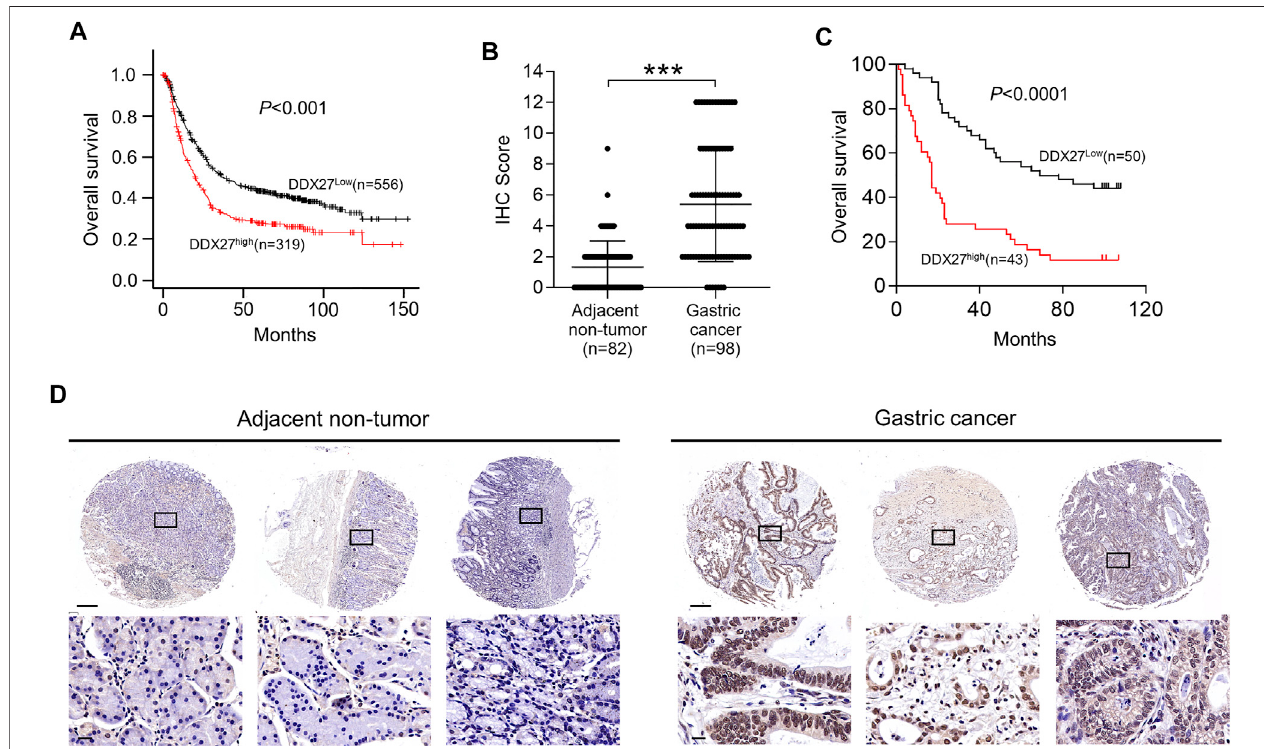
FIGURE2| HighDDX27expressionindicatedapoorclinicalprognosis. (A) Kaplan-Meieranalysisofoverallsurvival(OS)betweenGCpatientswithhigh( n =319)or low( n =556)DDX27expressionfromthedataset.( p < 0.001,bylog-ranktest). (B,D) IHCscoringofpairedadjacentnontumor( n =82)andGCtissues( n =98)[ (B) ,*** p < 0.001, by Student ’ s t-test] with the representative images of IHC staining for DDX27 protein levels (D) . Scale bars: 250 μ m (up) or 20 μ m (below). (C) Kaplan – Meier analysis was used to evaluate the DDX27 expression in patients with GC form tissue microarray ( p < 0.001, by log-rank test). n ≥ 3, the data are presented as the mean ± SD. DDX27 is a critical mediator of GC metastasis via